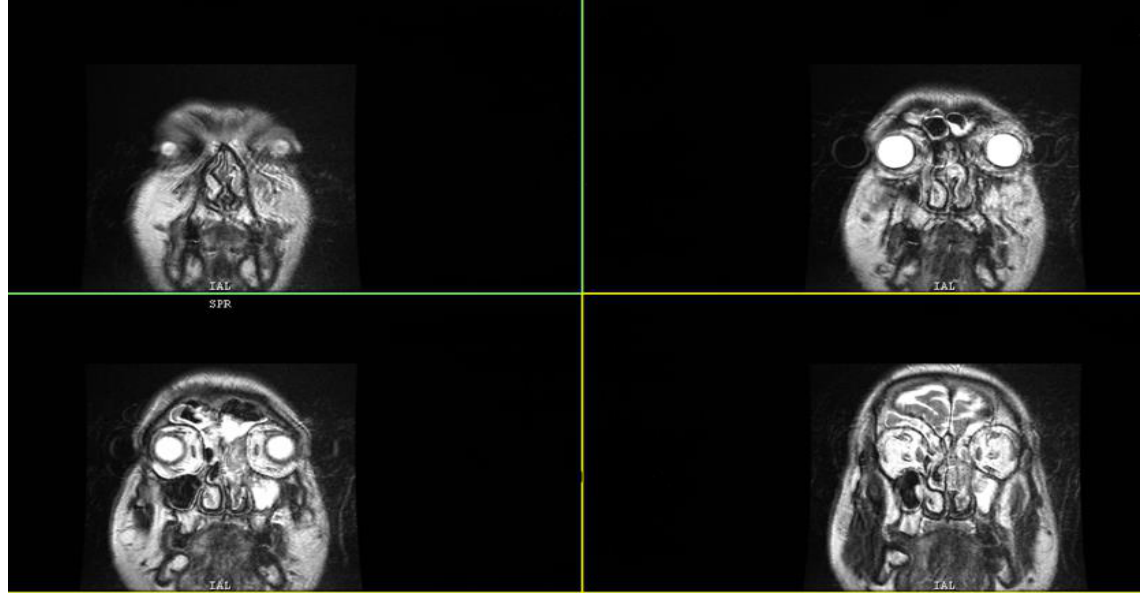
Figure 3. T2 coronal images showing left sided hyperintensity in frontal and maxillary sinuses denoting inflammatory reaction & iso to hypointensity in ethmoid and nasal turbinates in the same side denoting focus of necrotic tissue and fungal element.